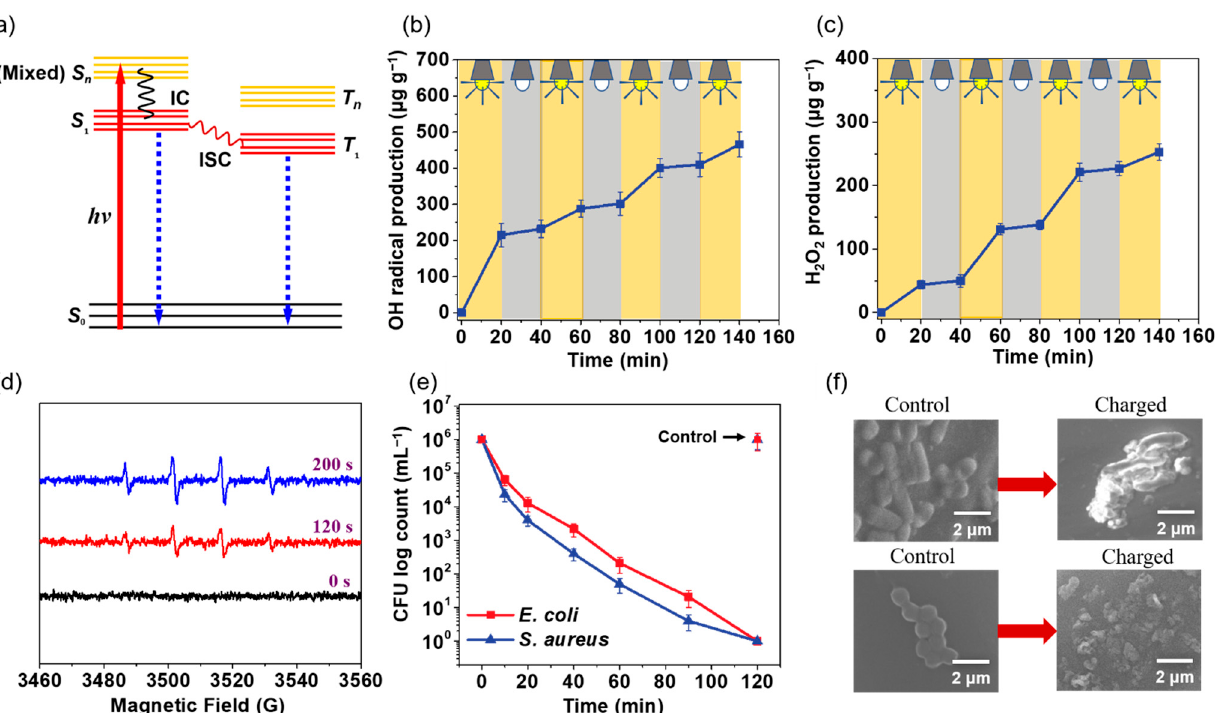
Figure 5. ( a ) Jablonski diagrams illustrating the photoexcitation process. ( b ) The released amount of OH • at different times. ( c ) The released amount of H 2 O 2 at different times. ( d ) The ESR signals for the G-SF/PVA BNM at different times. ( e ) The biocidal activity against E. coli and S. aureus of the G-SF/PVA BNM in irradiated conditions. ( f ) FE-SEM images of E. coli and S. aureus cells for the G-SF/PVA